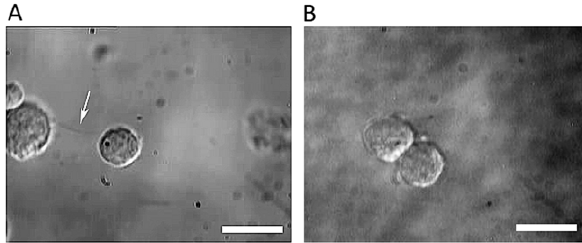
Figure 3. Adhesion of neural progenitor/stem cells (NSCs). A) NSC adhesion mediated by a long filopodial bridge (indicated by the white arrow); B) Surface adhesion of two neural progenitor cells. The scale bars denote 10 m